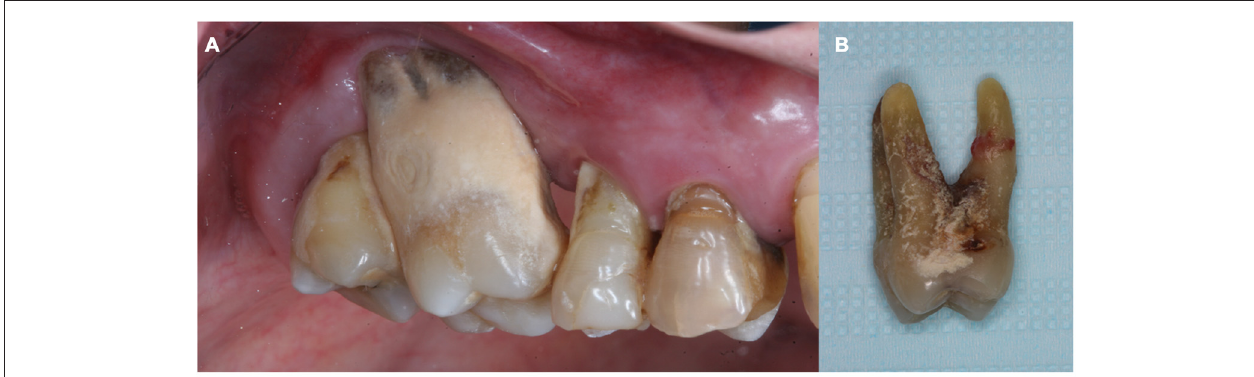
FIGURE 2 | (A) Teeth from a chronic periodontal patient presented dental calculus, gingival recession and attachment loss. (B) Molar tooth showed in (A) extracted due to advanced periodontal disease